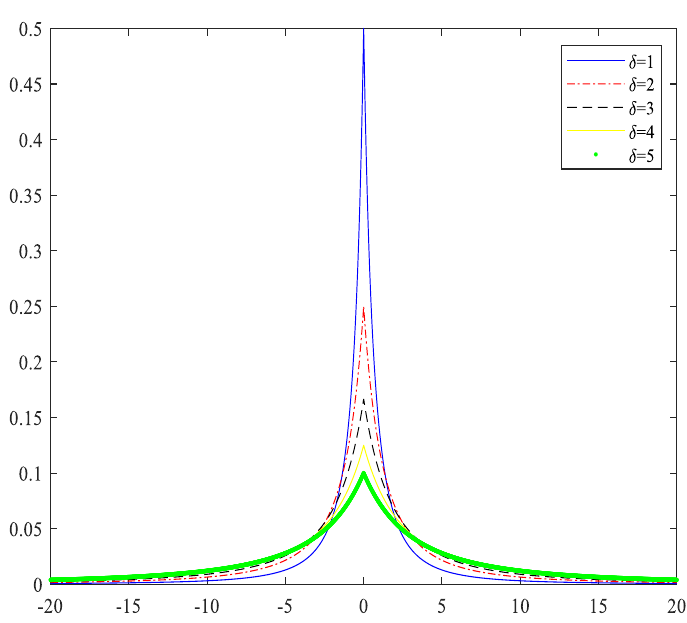
Figure 6. Comparison of δ value in GPD PDF plots.